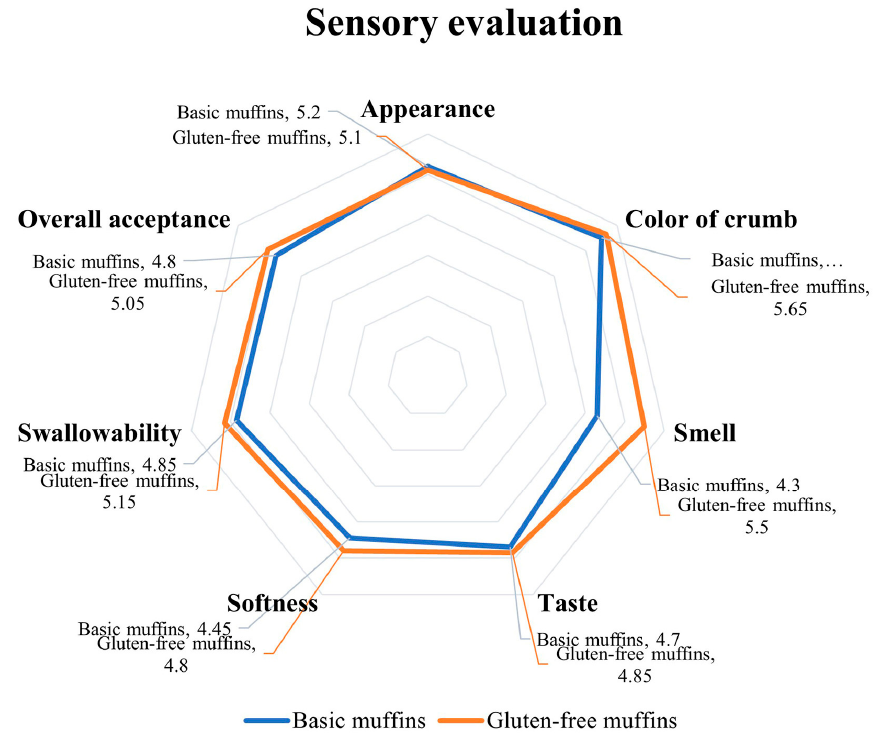
Figure 5. Sensory evaluation values of gluten ‐ free muffins from cassava flour.